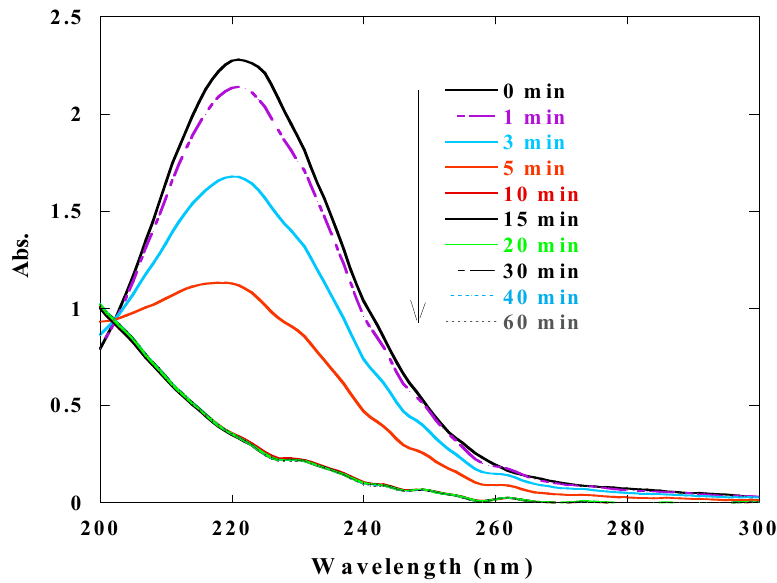
Figure 3. Absorption spectra of UV-irradiated IO 4- aqueous solution ([IO 4– ] = 0.5 mM, 20 ± 1 °C, irradiation intensity: 15 mW/cm²).